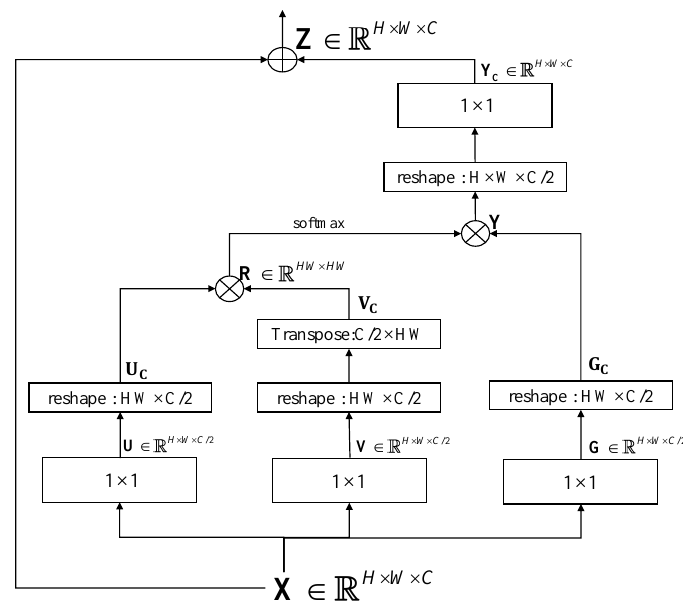
Figure 2. Framework of our non-local